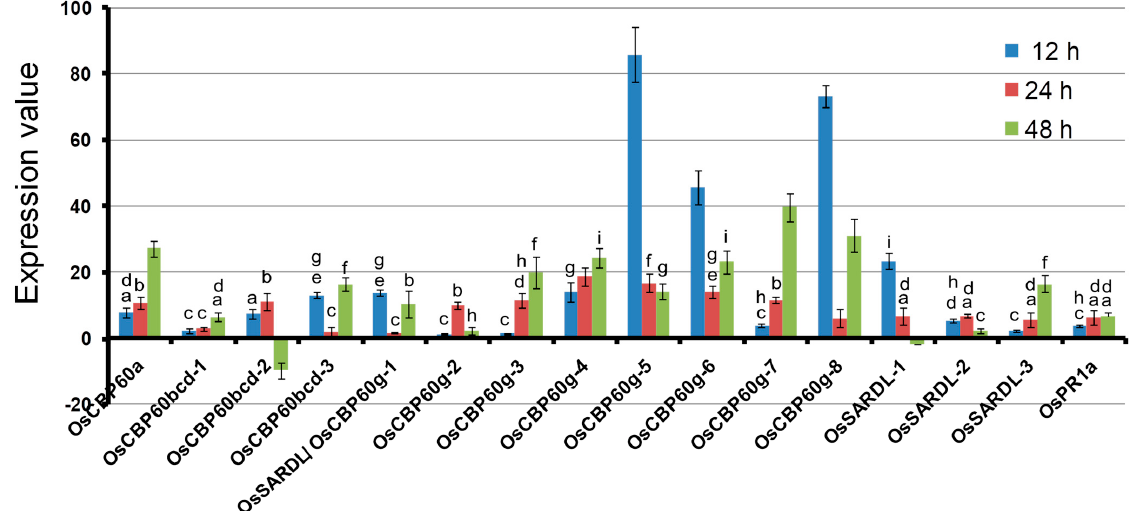
Figure 6. Transcriptional response of OsCBP60 genes in rice seedlings infected with M. oryzae . Rice seedlings were infected with the spores of M. oryzae and transcript levels were analyzed by qRT-PCR at 12, 24 and 48 h post infection. Relative transcript abundance (expression value) is expressed as fold-change relative to the mock treatment. OsPR1a expression served as a positive control. Results are representative of three independent experiments. Error bars represent standard error (SE) of mean for three replicates. Superscripts with the same letter are not significantly different ( p < 0.05) by one-way ANOVA-protected LSD test. Genes that were highly upregulated at 12 h post infection with X. oryzae pv. oryzae included OsCBP60g-3 (~25-fold induction) followed by OsCBP60g-7 (~19-fold induction), OsCBP60bcd-2 (~13-fold induction), while those expressed at the highest level at 48 h were OsCBP60a (~28-fold induction), followed by OsCBP60g-7 (~24-fold induction) and OsSARDL-1 (~19-fold induction) (Figure 7). In case of OsCBP60a, OsSARDL-1, OsCBP60g-4 and OsSARDL-3, a steady increase in expression was observed from 12–48 h.